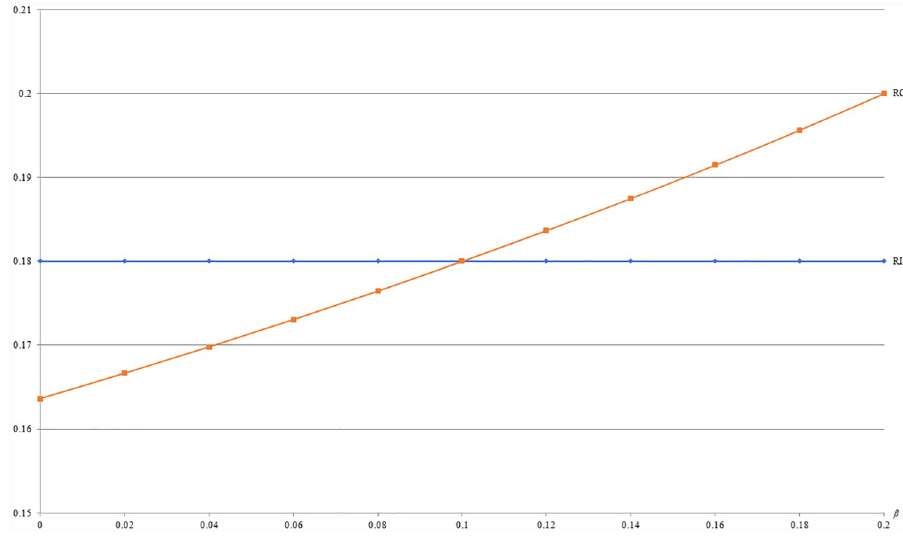
Fig 10. A comparison of revenues between IB and GB with respect to β .